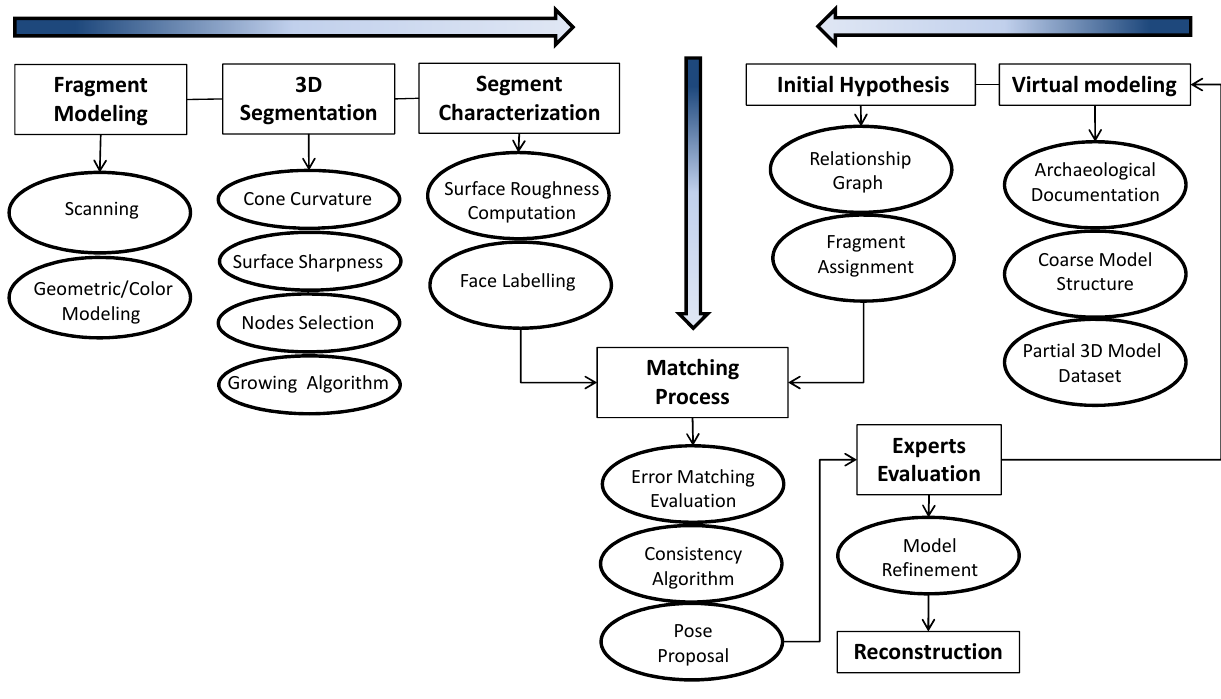
Figure 12. Overview of the virtual reconstruction